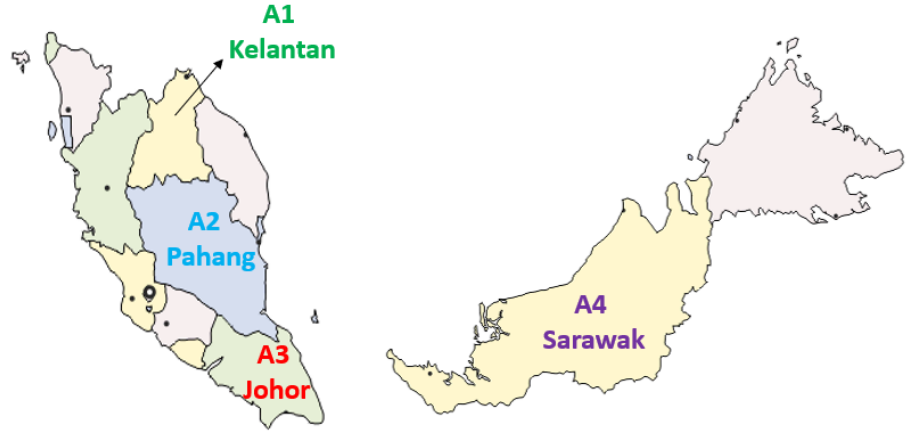
Figure 1. Location of the growth areas of the samples in Malaysia. The timber logs were sourced from four separate places and then cut into rough